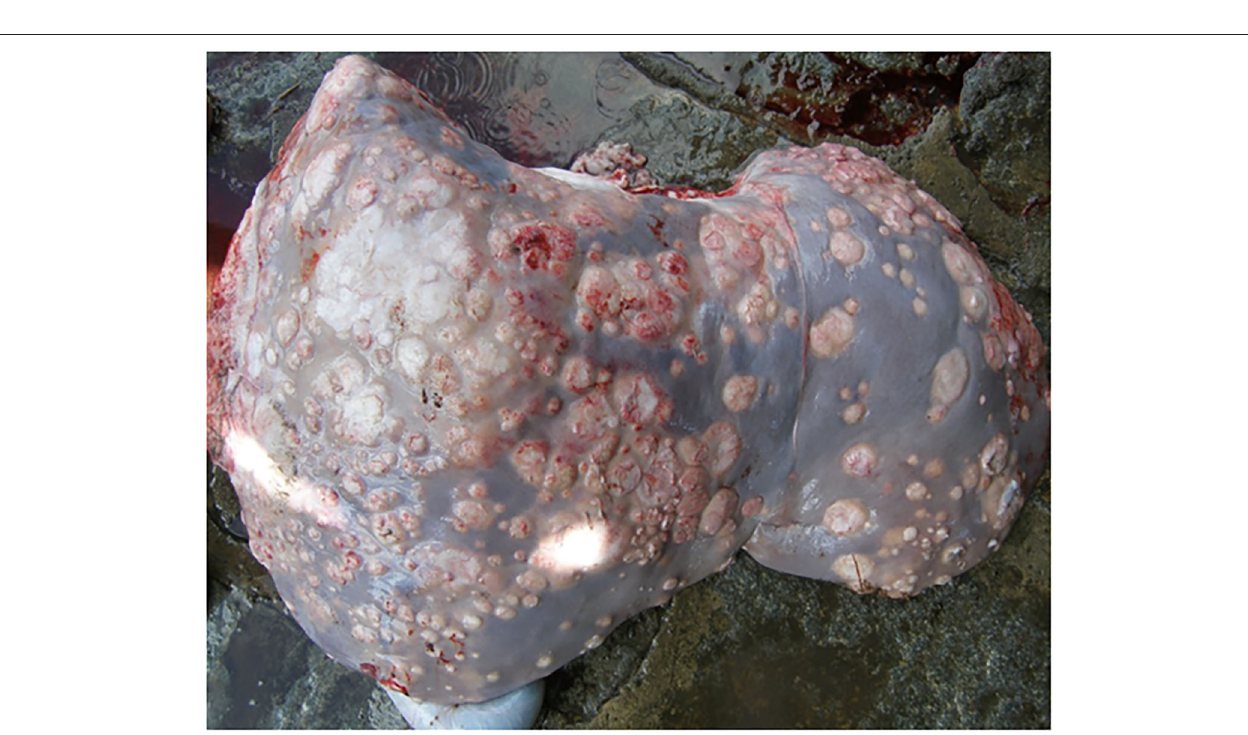
FIGURE 2 | Granulomatous lesions distributed in the liver of